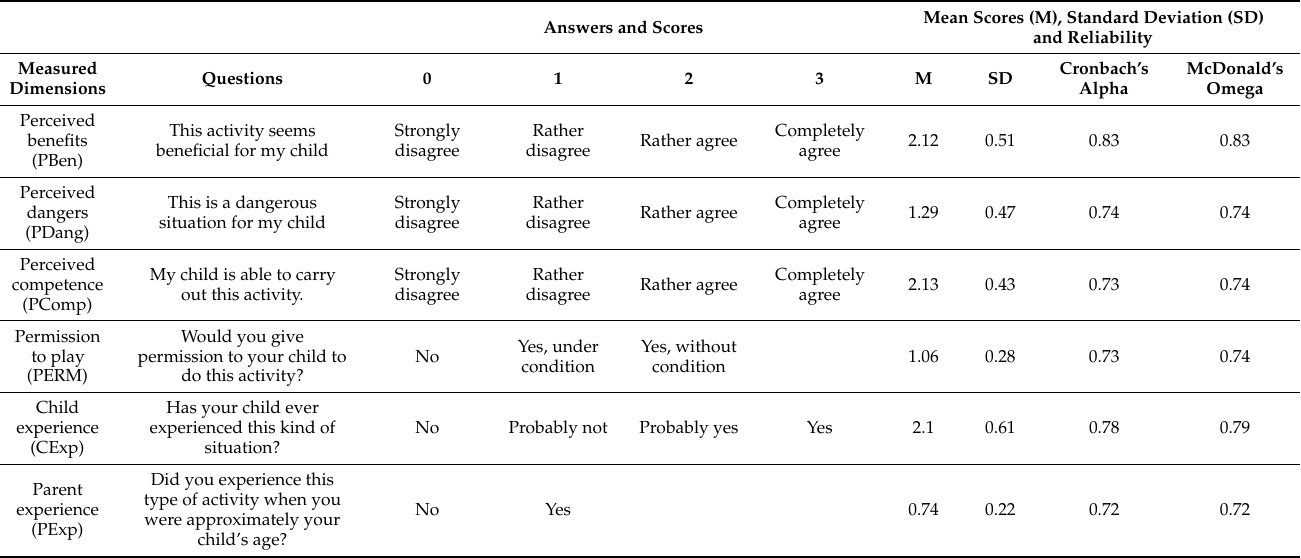
Table 2. For each dimension of the photo-based questionnaire, summary of the response scale and means, standard deviations, and reliability of the average scores (across situations). Answers and Scores Mean Scores (M), Standard Deviation (SD) and